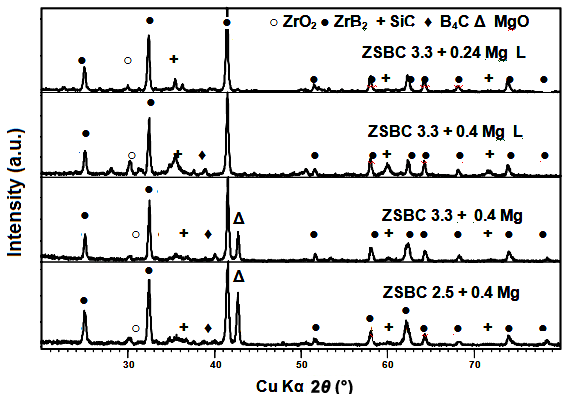
Fig. 11 XRD patterns of ZSBC samples after FT assisted reaction. L means after leaching with HCl